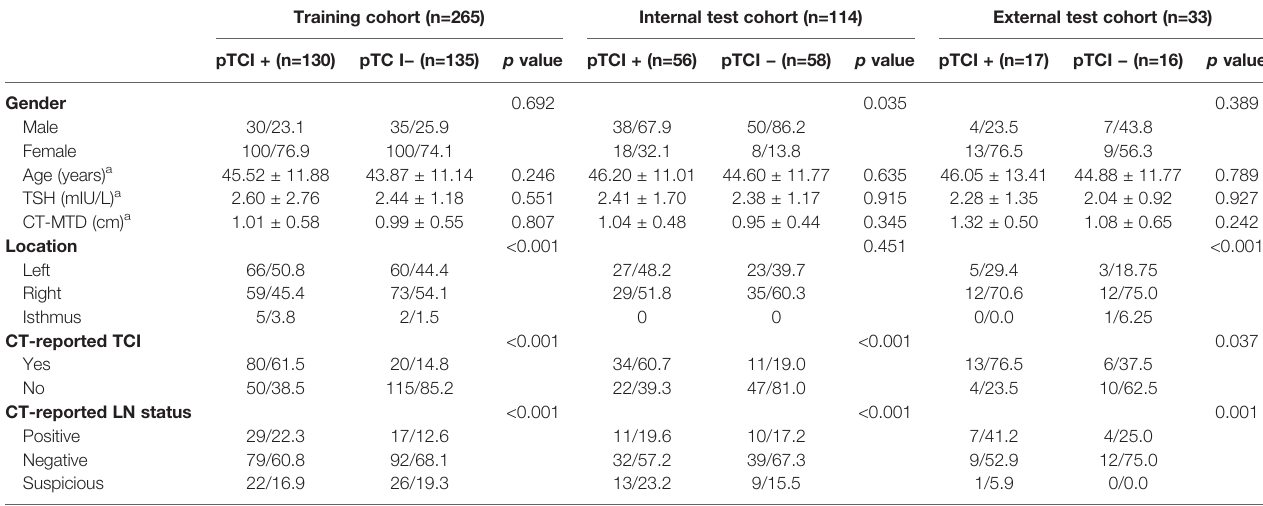
TABLE 1 | Clinicoradiological characteristics of the training, internal test, and external test cohorts. Training cohort (n=265) Internal test cohort